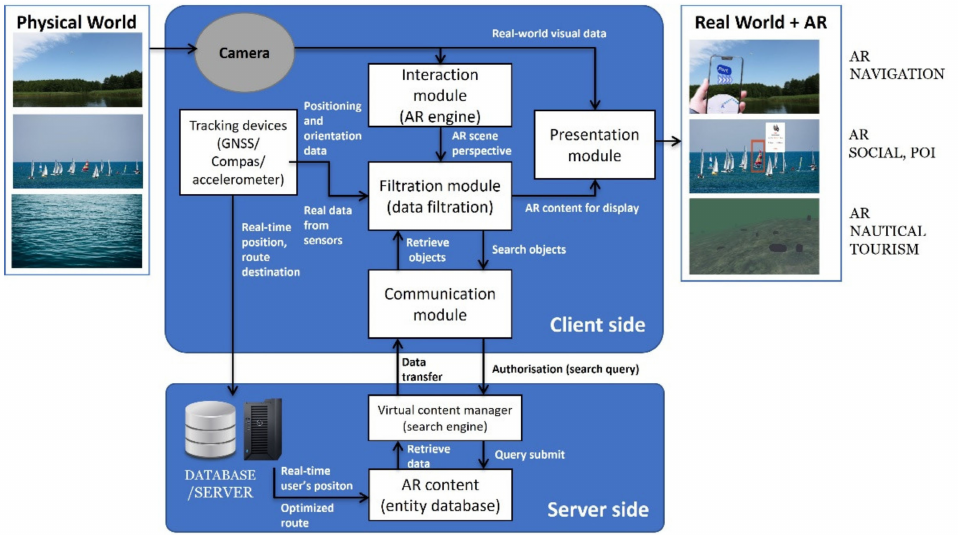
Figure 5. The overall architecture of the proposed AR shallow water application highlighting the major modules and their